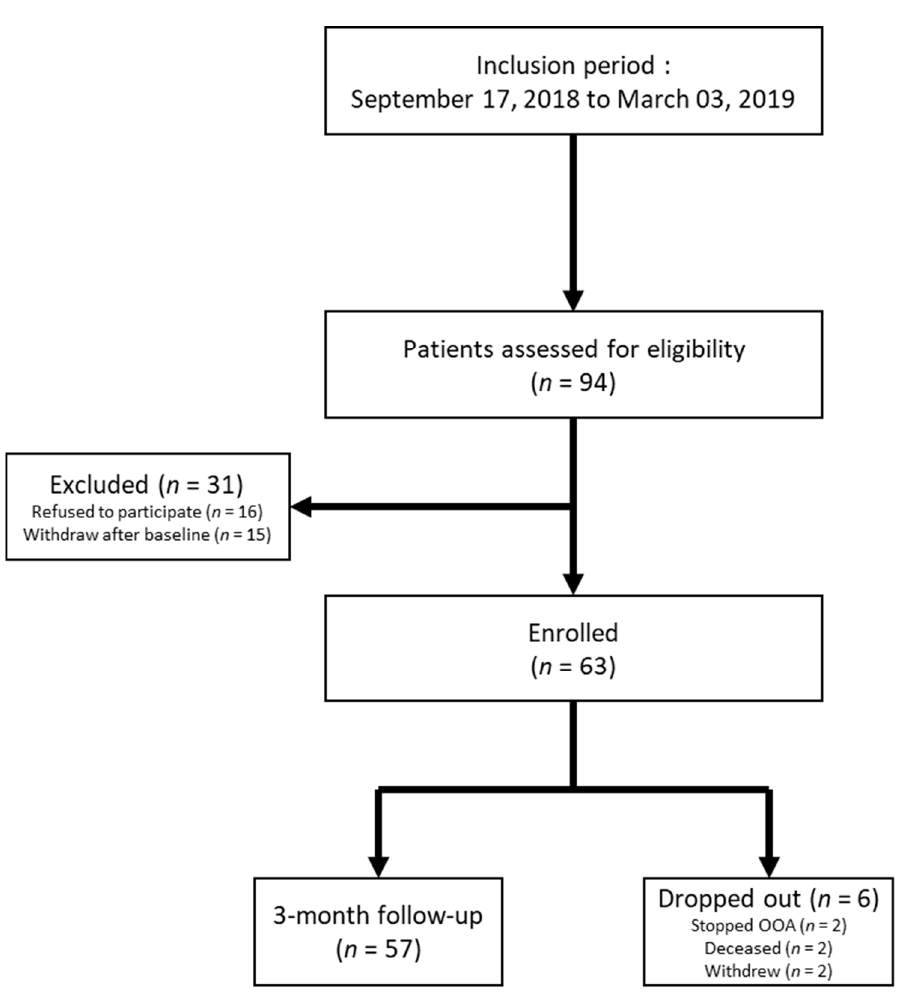
Figure 2. Study Flowchart. Caption: n = number of patients. Table 1. Patient Baseline